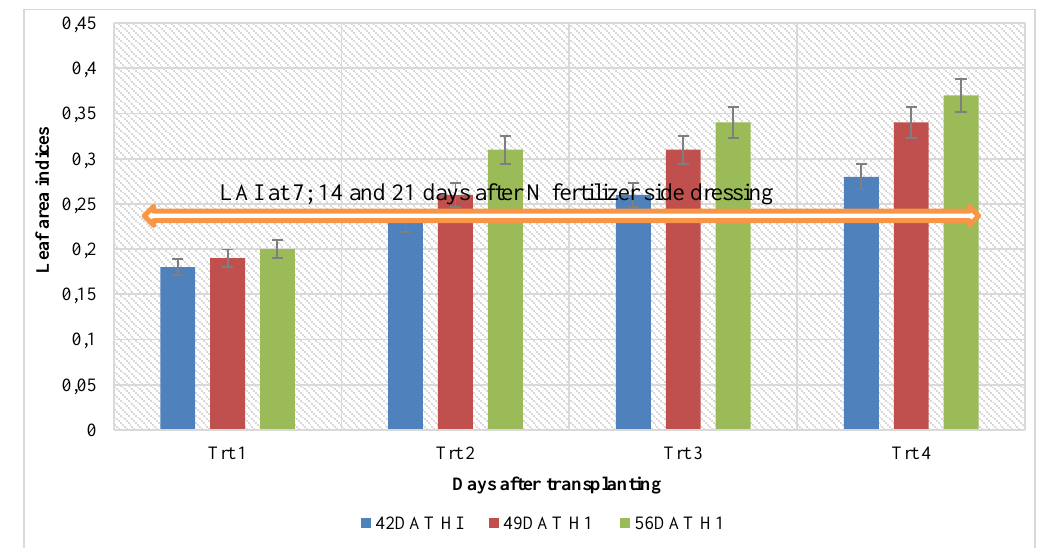
Figure 8b. LAI at 7; 14 and 21 days after N side dressing